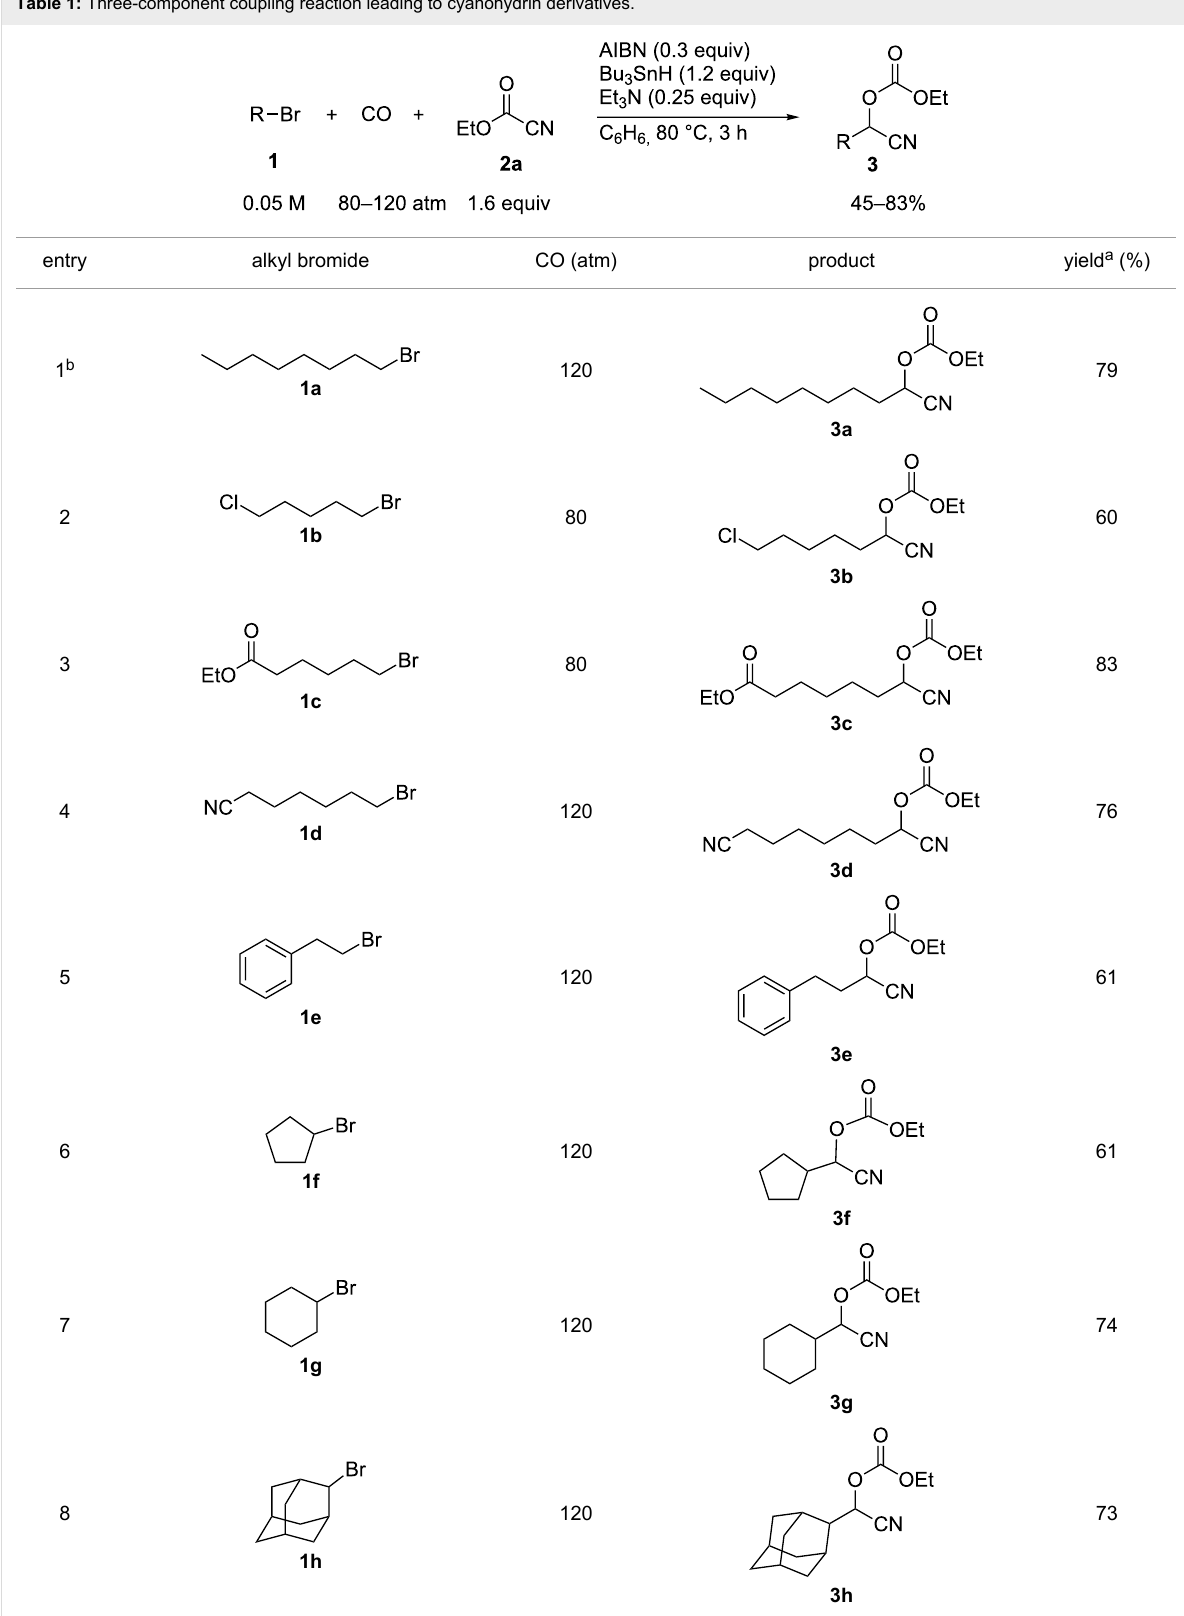
Table 1: Three-component coupling reaction leading to cyanohydrin